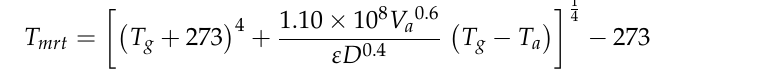
Table 2. RayMan model input data.